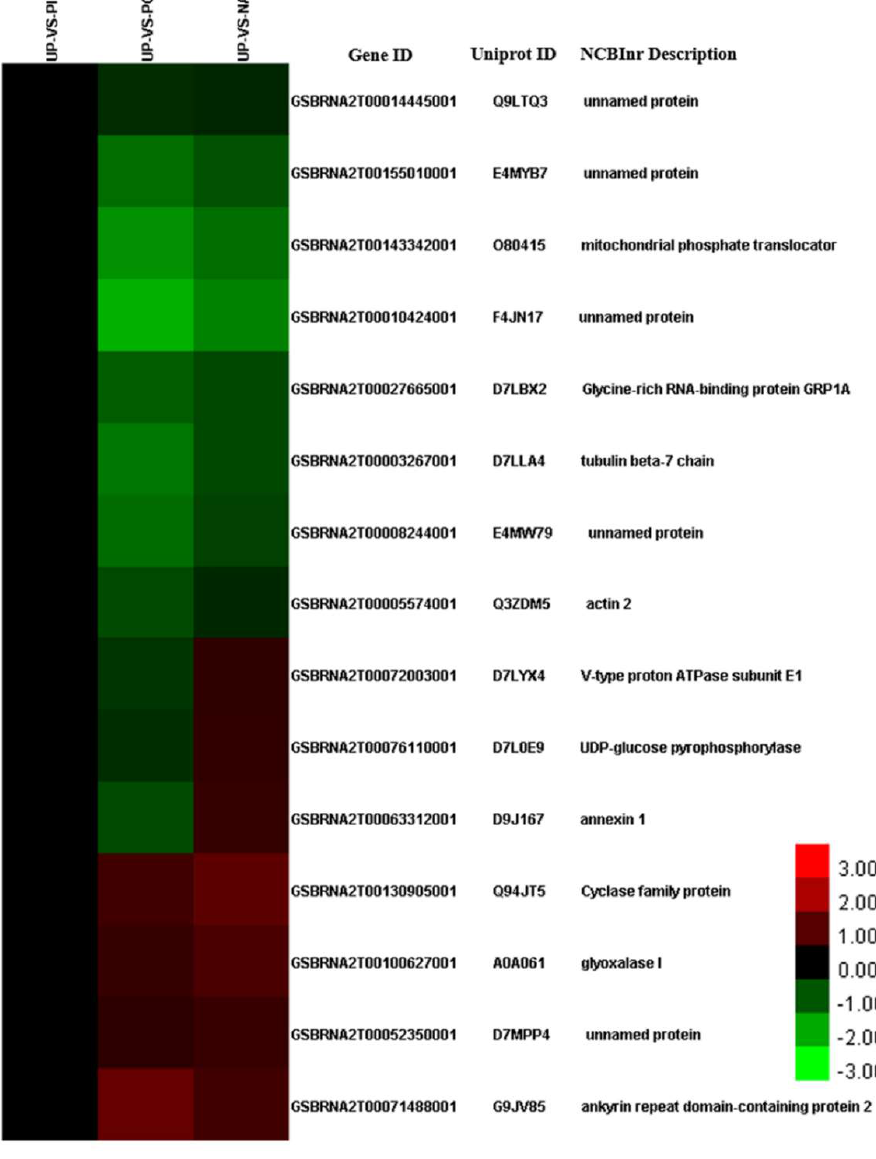
Figure 4. Cluster analysis of DAPs enriched in response to salt stress between UP-VS-PC, UP-VS-PI, and UP-VS-NA. The detailed information of these DAPs is listed in Table S6.